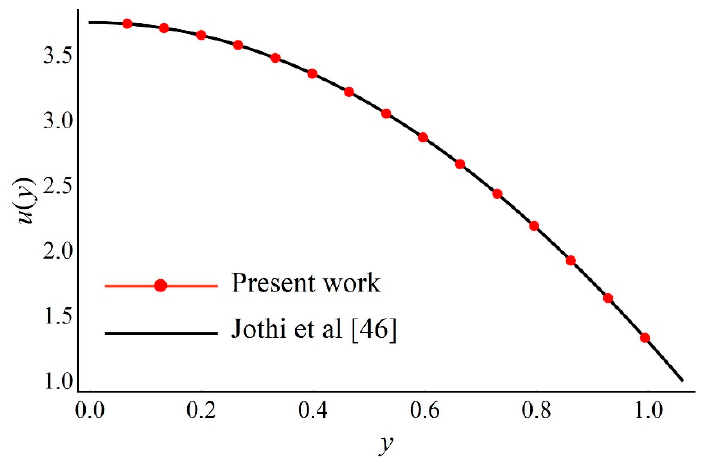
Figure 2. Comparison of the velocity profile of the present work with the velocity profile reported by Jothi [46].